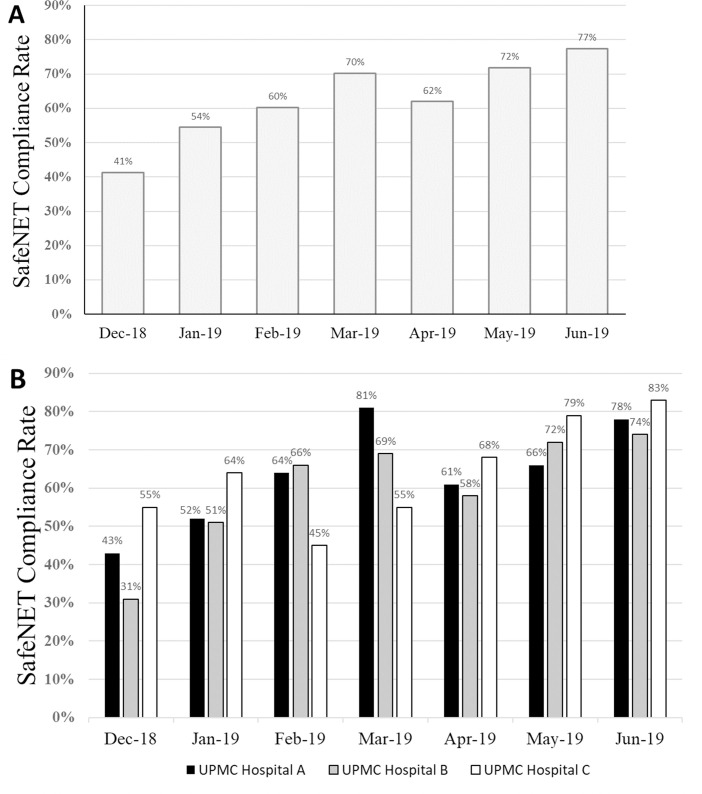
SafeNET compliance over time by hospital facility.Compliance rates are displayed during a 7-month pilot period (A) and broken down by participating facility (B).